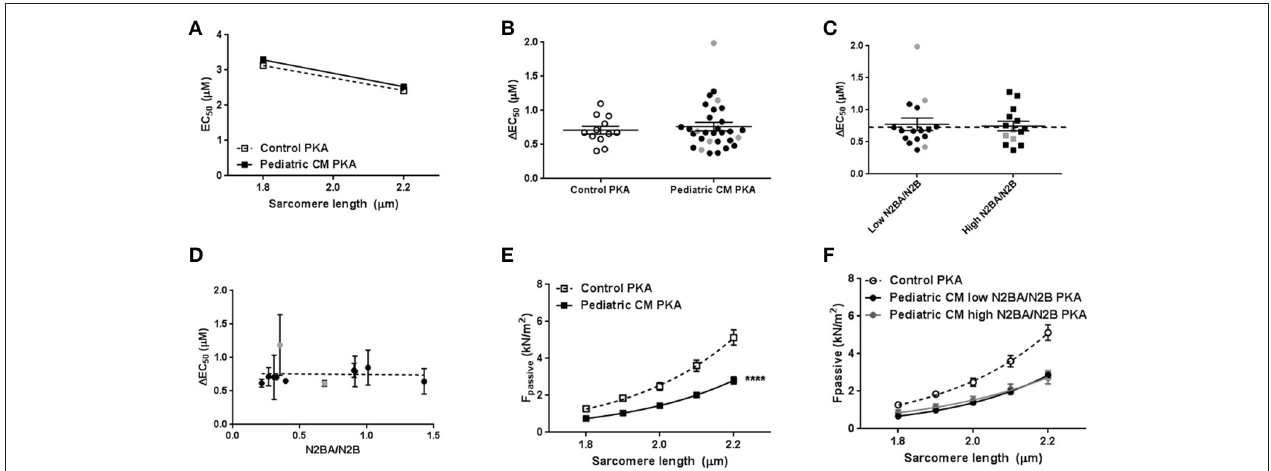
FIGURE 4 | Restoration of sarcomere function after incubation with exogenous PKA. (A) Exogenous PKA restored myofilament Ca 2 + -sensitivity in pediatric CM ( N = 11, n = 30) to control ( n = 5, n = 12) values. (B) Exogenous PKA eliminated the difference in length-dependent activation ( 1 EC 50 ) between pediatric CM patients with higher N2BA/N2B ratio (N2BA/N2B > 0.65, N = 5, n = 14) and pediatric CM patients who had lower N2BA/N2B ratio (N2BA/N2B < 0.4, N = 6, n = 16) (shown relative to control value). Dotted line indicates control values. (C) There was no difference between patients with high or low N2BA/N2B ratio with respect to 1 EC 50 after incubation with exogenous PKA. (D) Mean 1 EC50 per sample measured after incubation with exogenous PKA plotted against the N2BA/N2B ratio did not show a significant correlation between 1 EC50 and N2BA/N2B. (E) Exogenous PKA did not affect F pass in controls or pediatric CM. F pass remained significantly